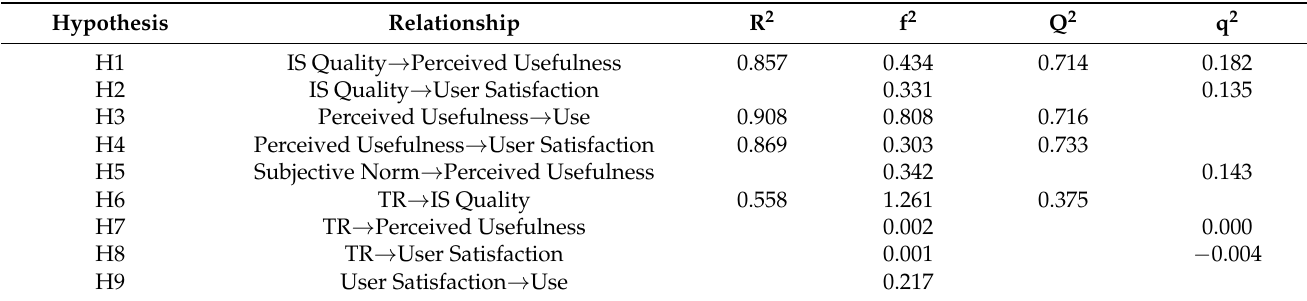
Table 7. Summary of R 2 , f 2 Q 2 , and q 2